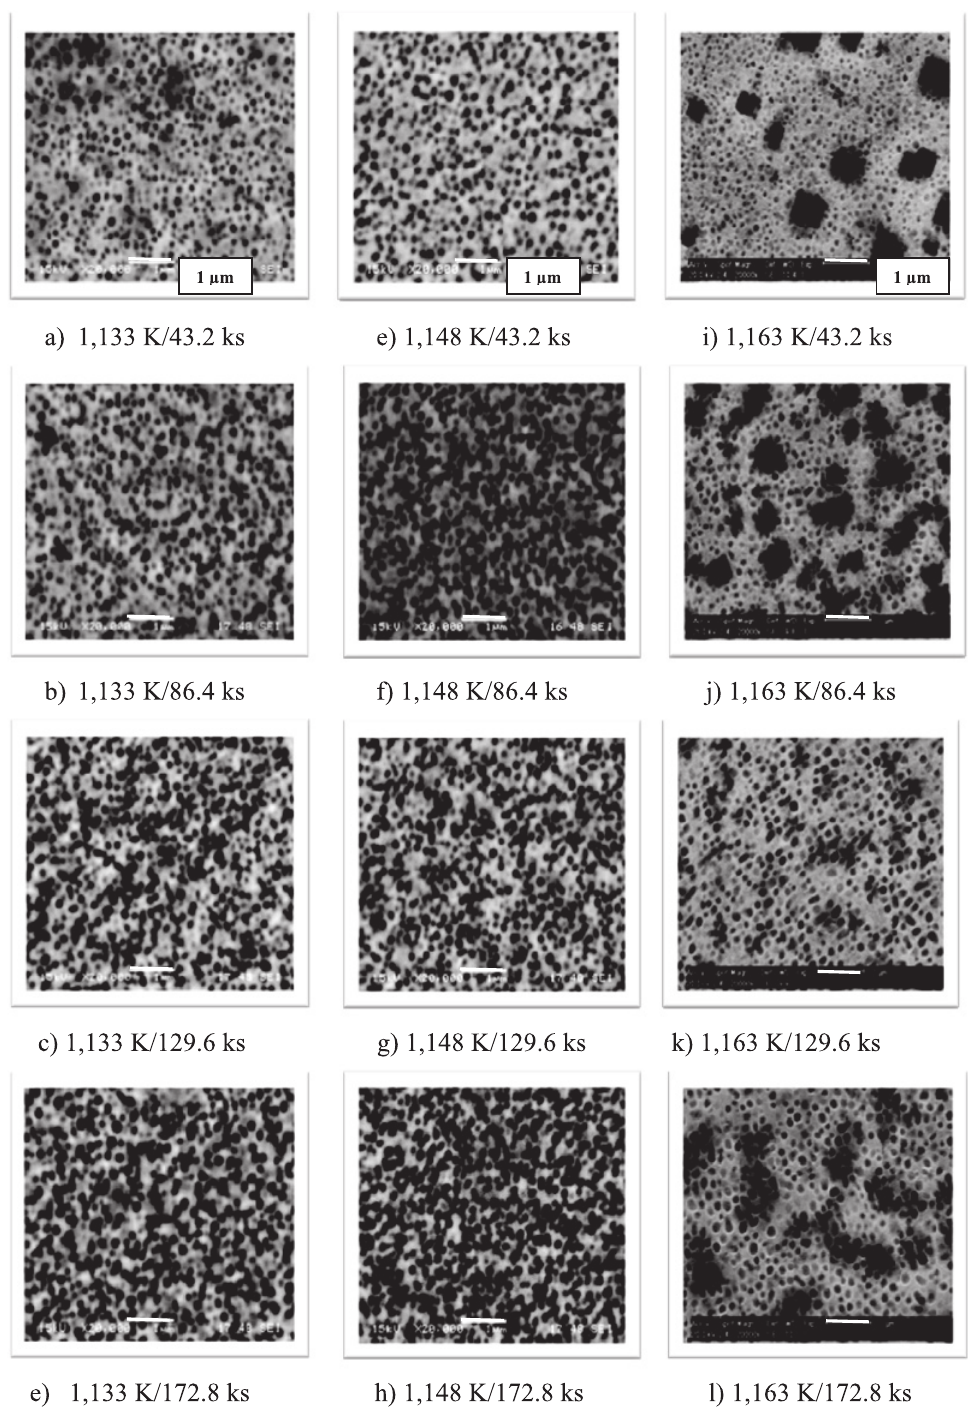
Fig. 4: Microstructures of specimens with solutionizing temperature of 1,478 K/14.4 ks and various aging